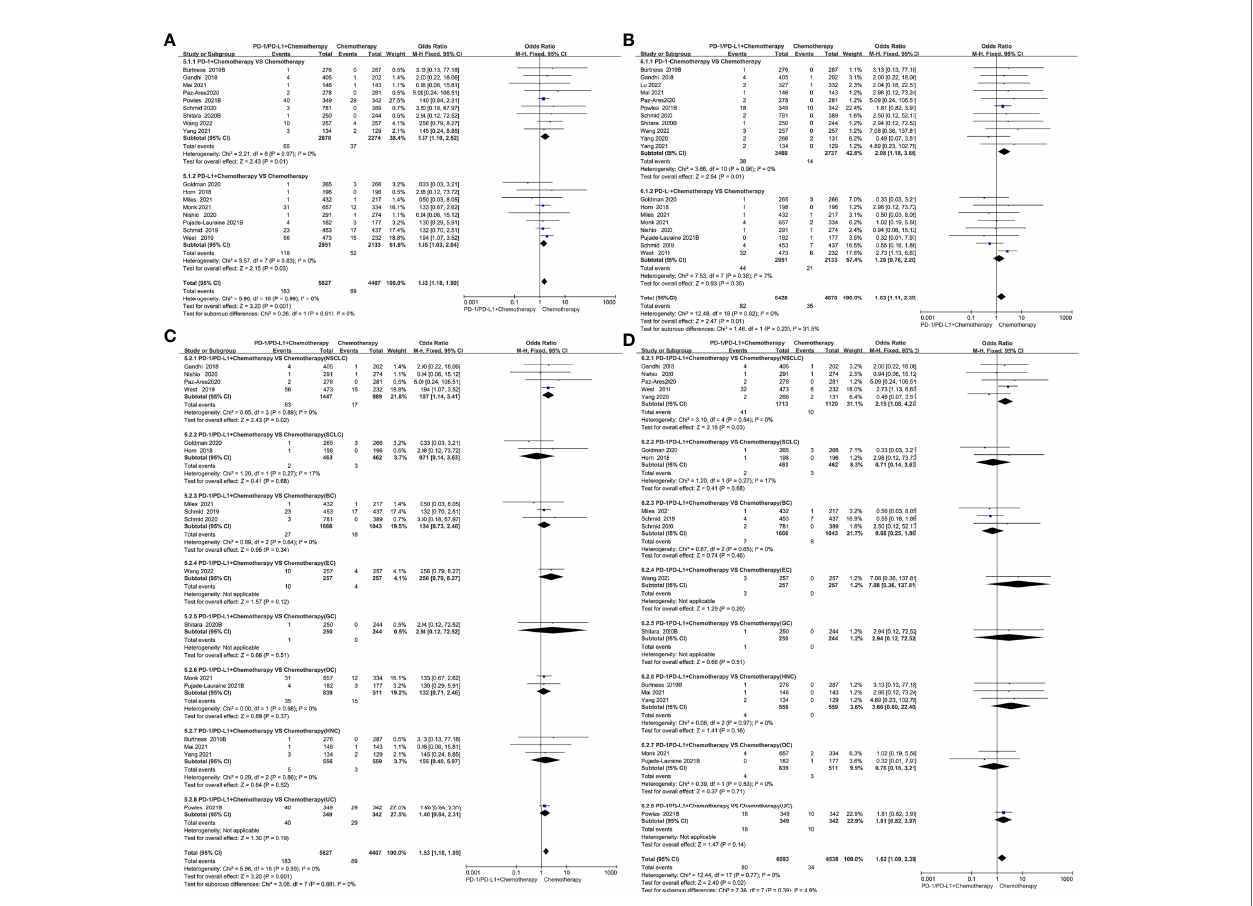
FIGURE 5 | Forest plots of the risk of all-grade and grade 3-5 cardiotoxicity calculated by the fi xed effect model. (A) The risk of all-grade cardiotoxicity in PD-1/PD-L1 inhibitors + Chemotherapy VS Chemotherapy group. (B) The risk of grade 3-5 cardiotoxicity in PD-1/PD-L1 inhibitors + Chemotherapy VS Chemotherapy group. (C) The risk of all-grade cardiotoxicity in PD-1/PD-L1 inhibitors + Chemotherapy VS Chemotherapy group (subgroup analysis was performed based on tumor types). (D) The risk of grade 3-5 cardiotoxicity in PD-1/PD-L1 inhibitors + Chemotherapy VS Chemotherapy group (subgroup analysis was performed based on tumor